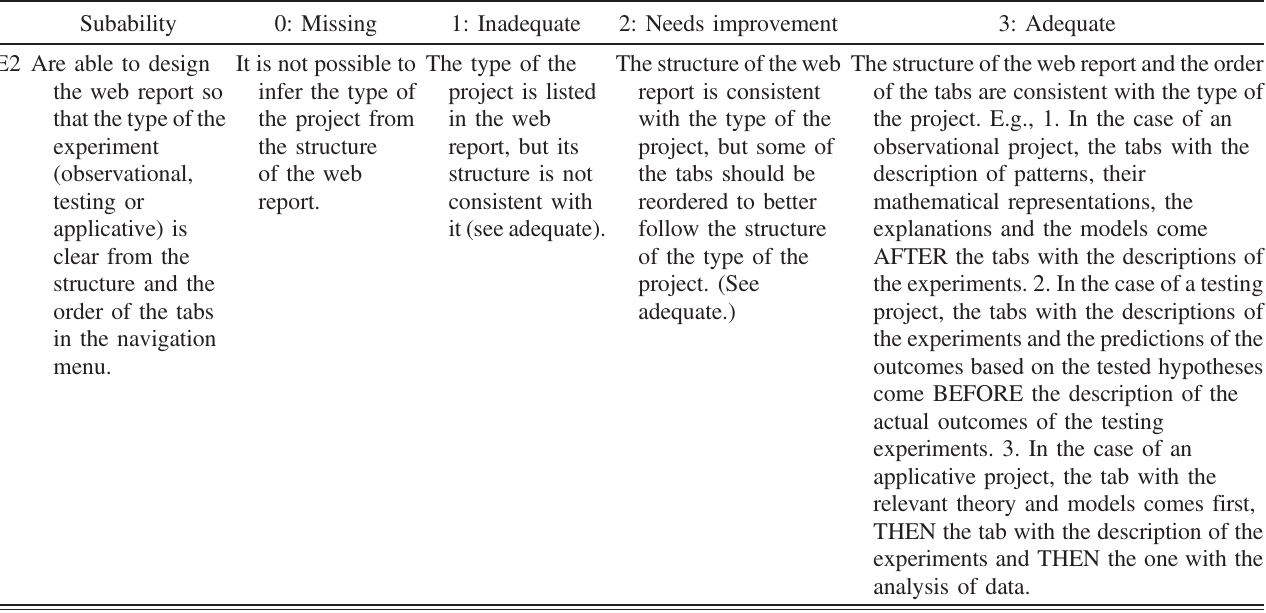
TABLE V. The second line of the new rubric for the ability of writing a report in the form of a web page.